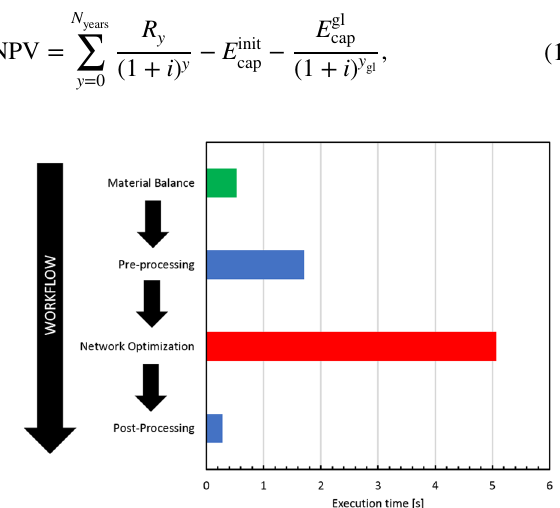
Fig. 13 Initial CAPEX as a function of liquid capacity. The gas lift system is not included in this